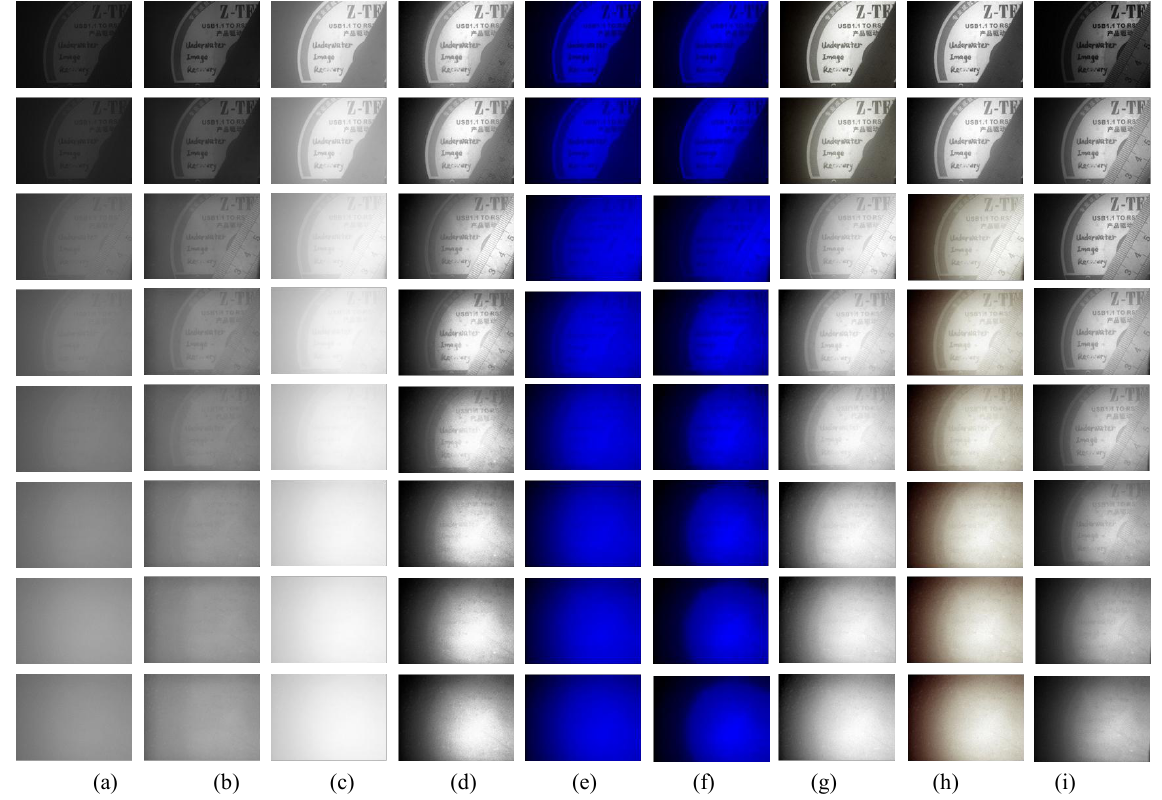
Figure 4. Underwater image enhancement results with different media concentrations (a)Original (b)CLAHE (c)GC (d) HE (e)ICM (f)RD (g)RGHS (h)UCM (i)proposed